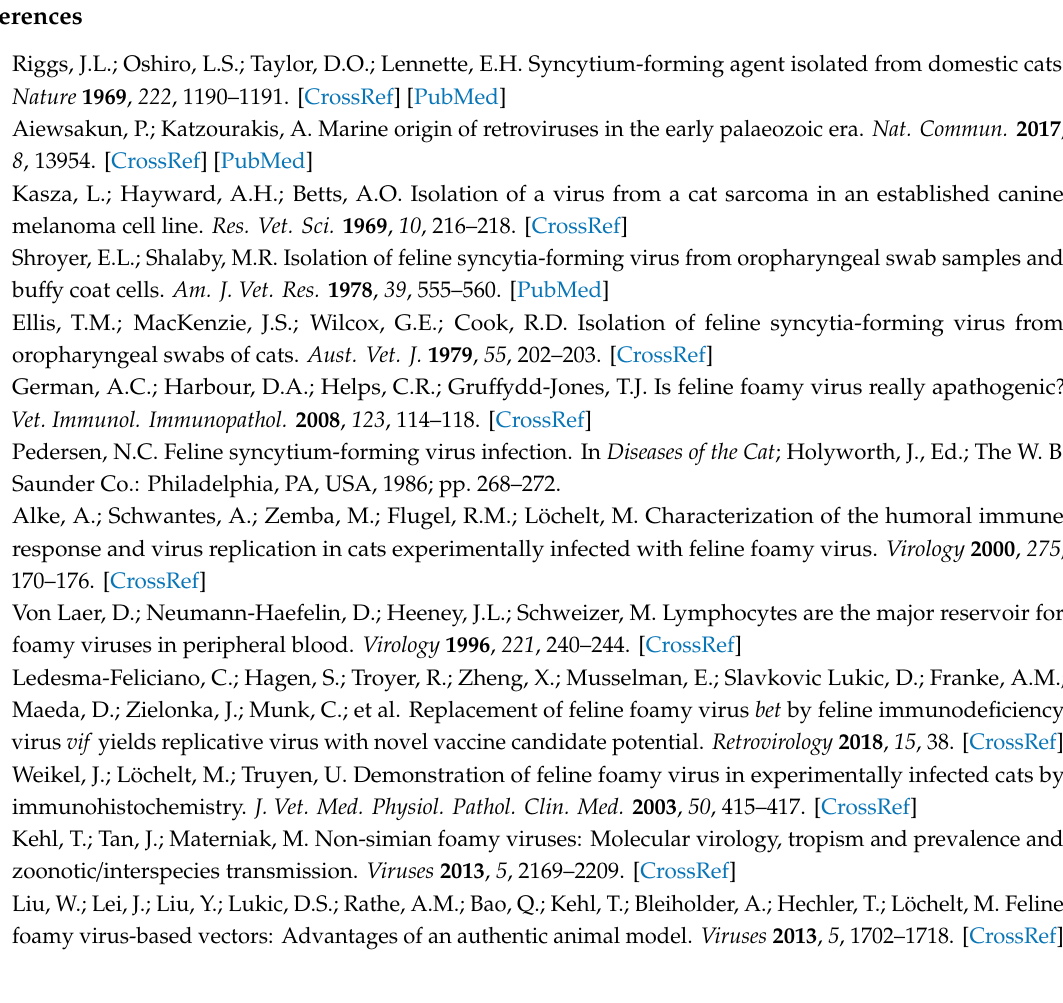
Table S1: Antibody marker combinations used for PBMC phenotype analysis through flow cytometry. Table S2: FFV prevalence and chi-square analysis data for CKD